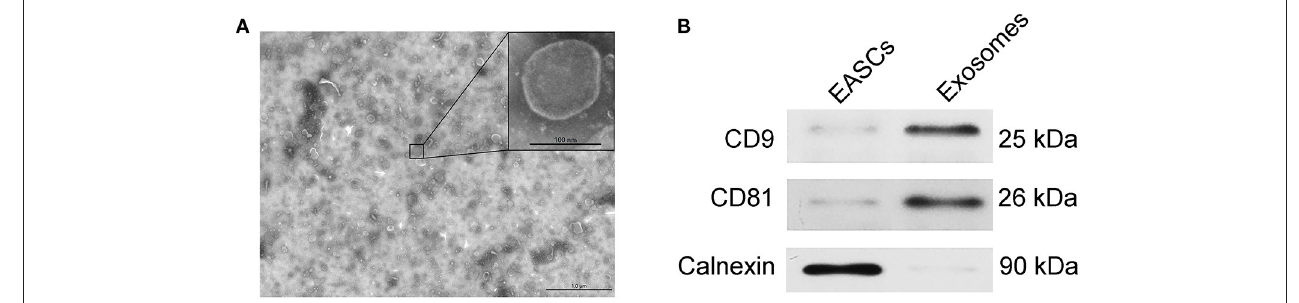
FIGURE 3 | Identification of exosomes from EAT. (A) Electron micrographs of exosomes. (B) The protein expression levels of CD9, CD81 and calnexin in EAT-derived exosomes.